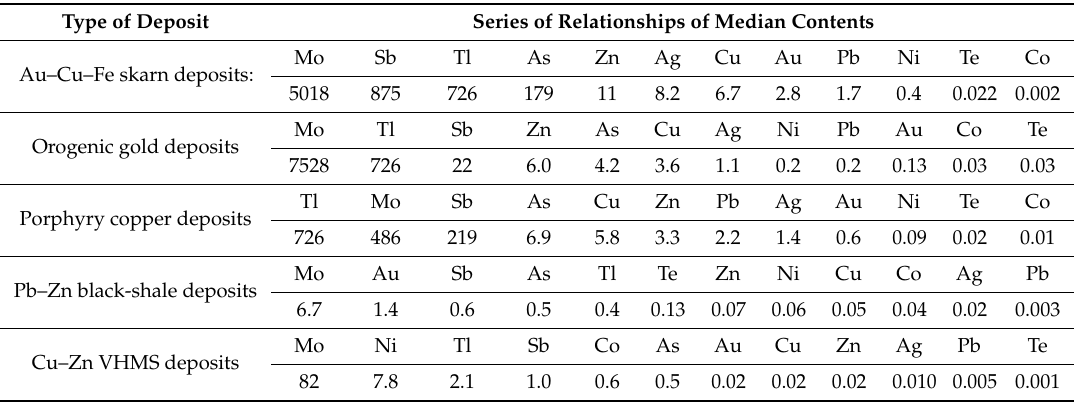
Table 5. Ranges of ratios of median contents of chemical elements, calculated for nodular pyrite from the Bazhenov Formation normalized to pyrite from major ore-formational types of ore deposits. Type of Deposit Series of Relationships of Median